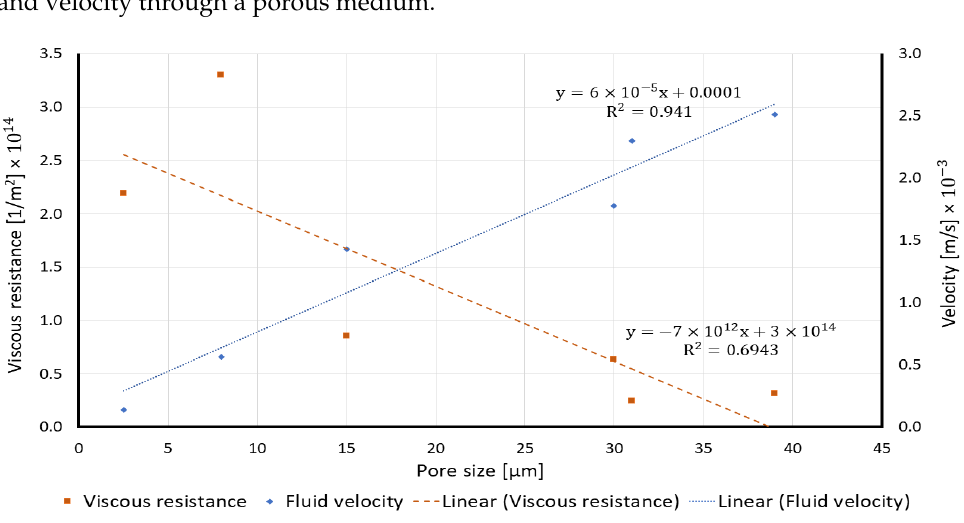
Table 5. Parameters required to model the porous zone in the Fluent Model.